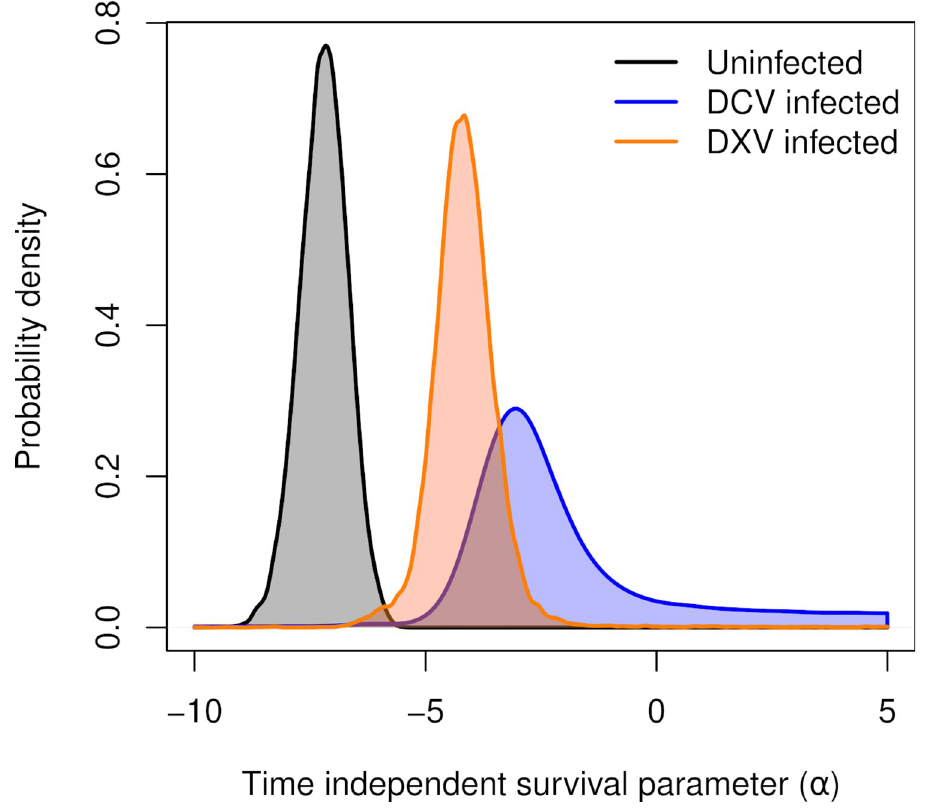
Fig 4. Posterior distributions for the time-independent survival of uninfected individuals ( α individuals ( α C ), and DXV infected individuals ( α X